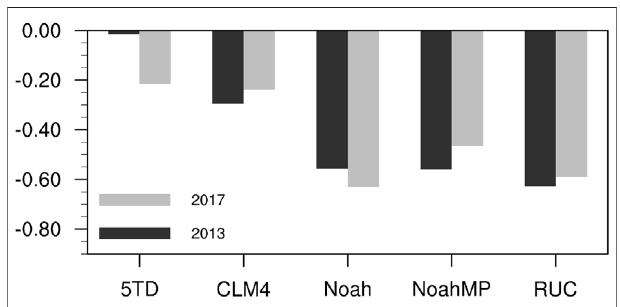
FIGURE 7 | The differences in areal mean ET (mm day − 1 ) over the study region (outlined boxes in Figure 2A ) between the model simulations and GLEAM data for the summer of 2013 (black) and 2017 (gray).